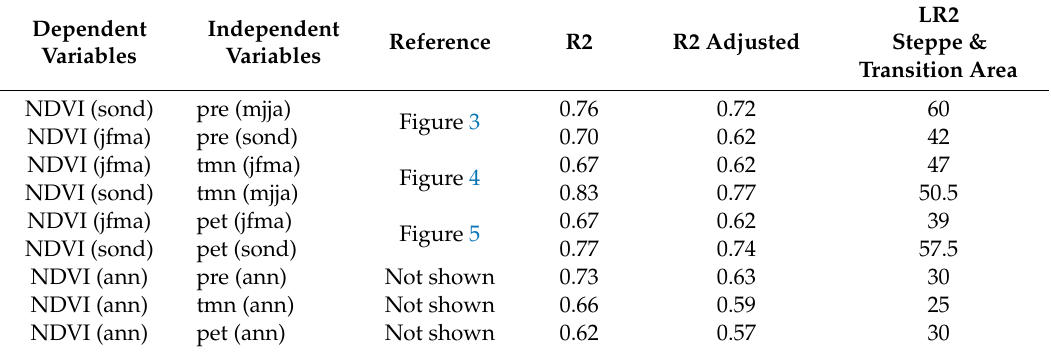
Table 1. Geographically weighted regression (GWR) analysis for NDVI data as a measure of aboveground net primary productivity (ANPP) using different climatic variables. Most significant results are shown in Figures 3–5, while those with less significance are not shown.